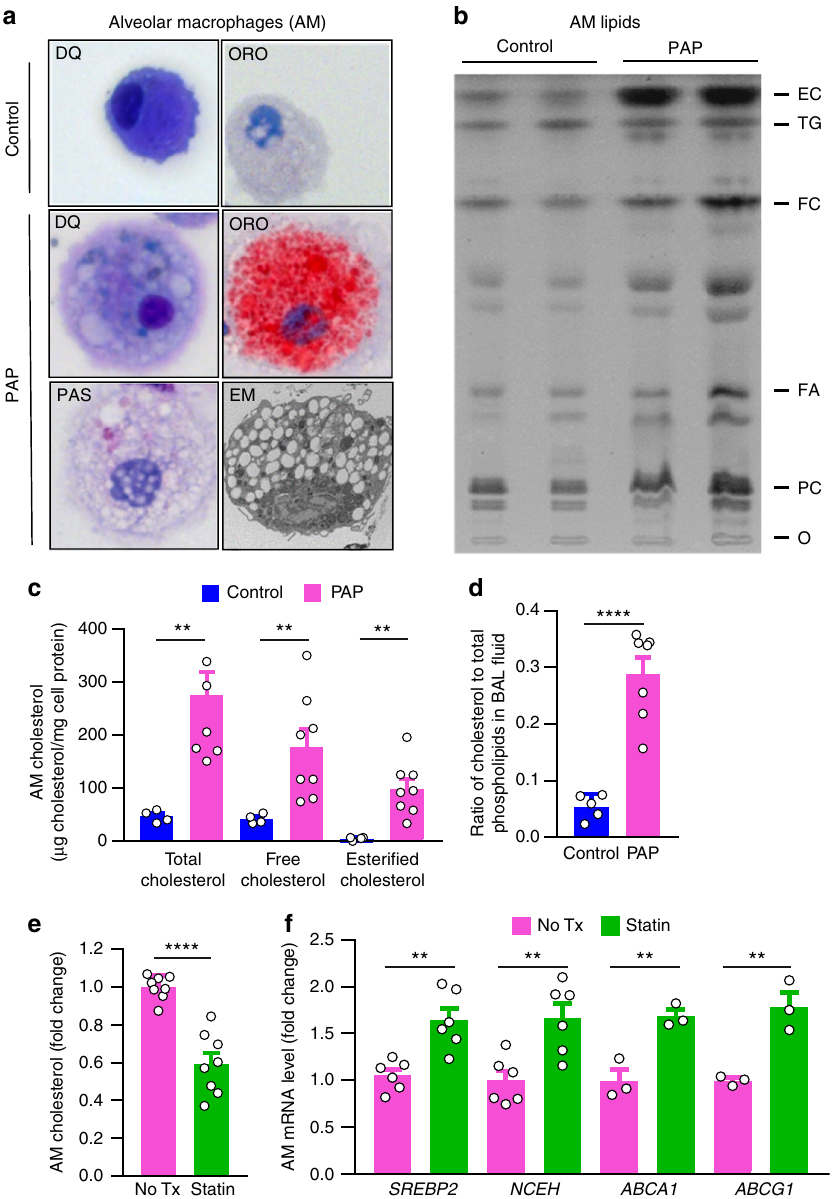
Fig. 2 Cholesterol accumulation in human PAP alveolar macrophages and correction by statin. a Human alveolar macrophages (AMs) stained with Diff- Quick (DQ), Oil-red O (ORO), periodic acid – Schiff (PAS), or electron microscopy (EM). b Thin-layer chromatography of AM total lipids from healthy people (control) or PAP patients (PAP). c AM cholesterol levels in PAP or controls ( n = 8 PAP/4 control). d The ratio of cholesterol to total phospholipids in pulmonary surfactant of PAP or controls ( n = 7 PAP/5 control). e Total cholesterol and f mRNA levels for SREBP2, NCEH, ABCA1 , ABCG1 in PAP AMs without and after statin treatment for 24 h ex vivo ( n = 3 – 6 per group). Data are mean ± SD, statistical differences determined by ANOVA with Bonferroni ’ s post hoc test. * P < 0.05, ** P < 0.01, *** P < 0.001, **** P <